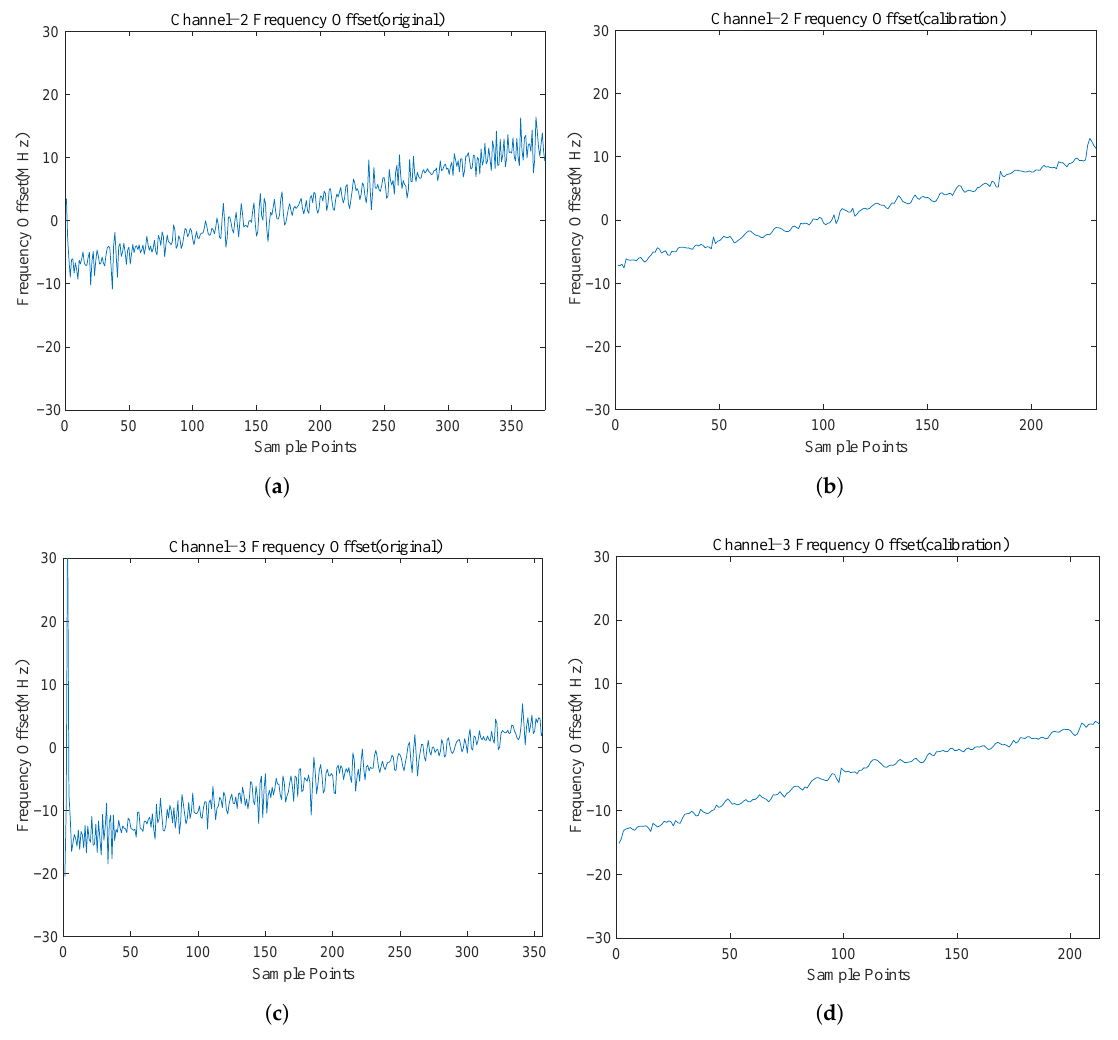
Figure 9. The instantaneous frequency measurement (IFM) results of the correct Channel 2 and 3: ( a ) the original IFM result of Channel 2; ( b ) the calibrated IFM result of Channel 2; ( c ) the original IFM result of Channel 3; ( d ) the calibrated IFM result of Channel